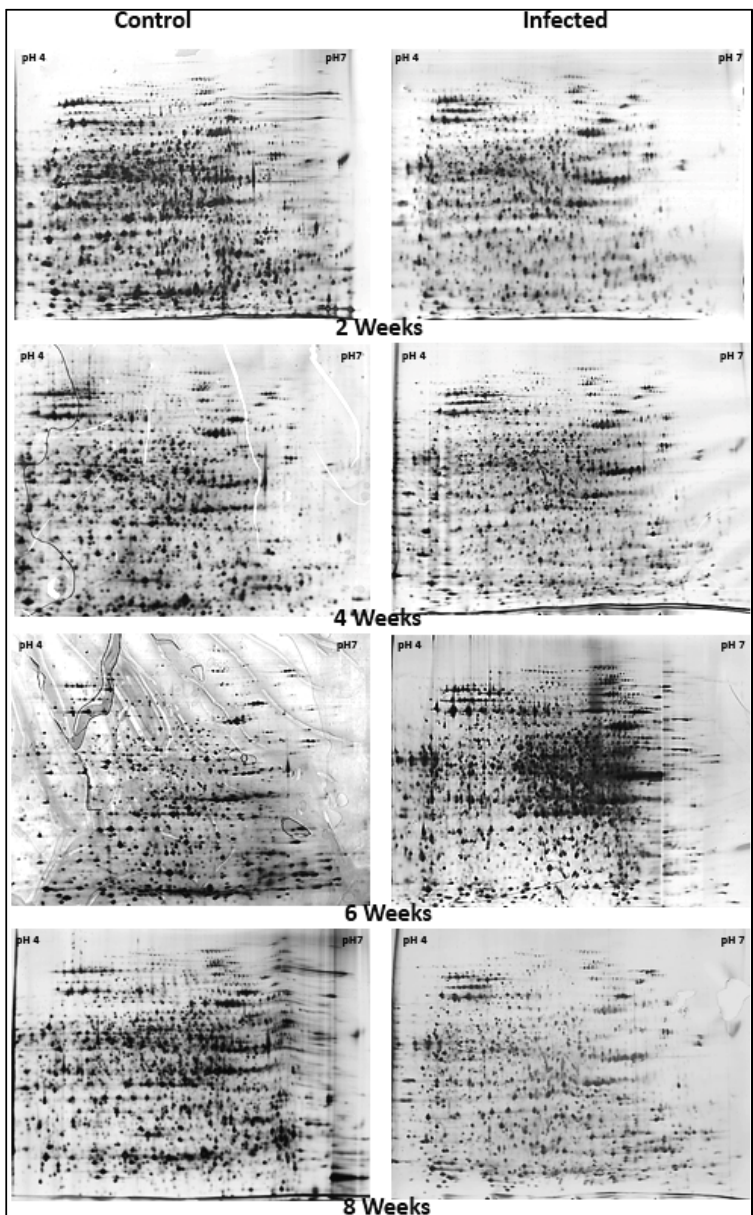
Figure 1. Representative 2-DE profiles of control and infected oil palm root proteins. Root proteins from control and infected oil palm tissues were harvested at two, four, six, the left and relative molecular mass declines from the